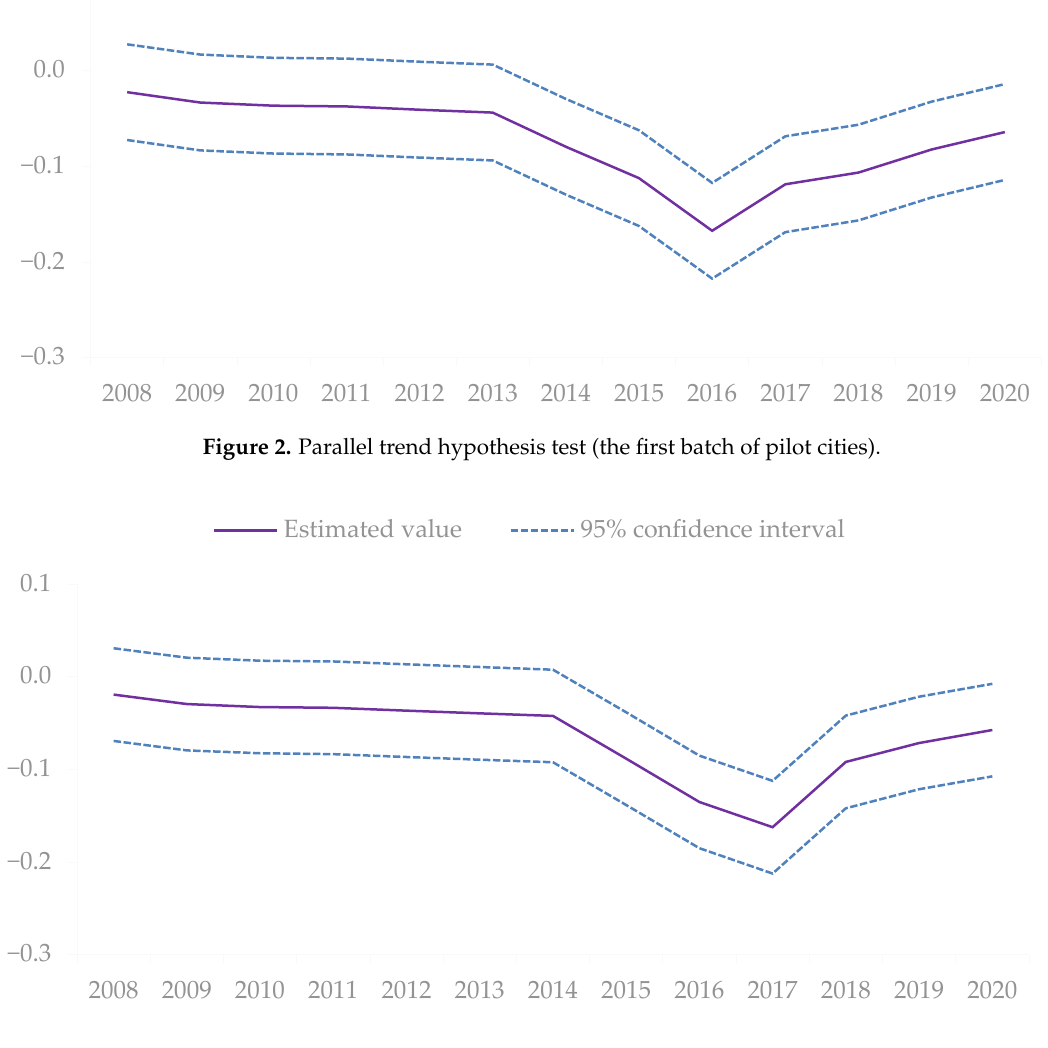
Figure 3. Parallel trend hypothesis test (the second batch of pilot cities).